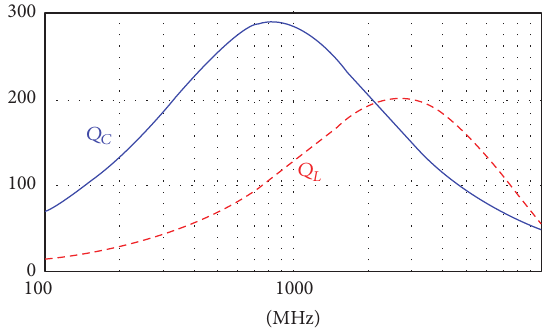
Figure 7: Quality factor 𝑄 𝐿 of the diagonal entries of the impedance matrix Z 𝐿 and quality factor 𝑄 𝐶 of all entries of the admittance matrix Y 𝐶 , for the antenna tuner of Section